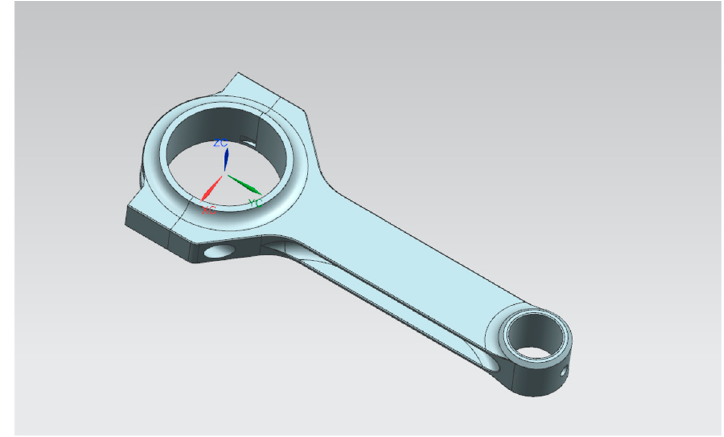
Figure 3. The automobile connecting rod part model.